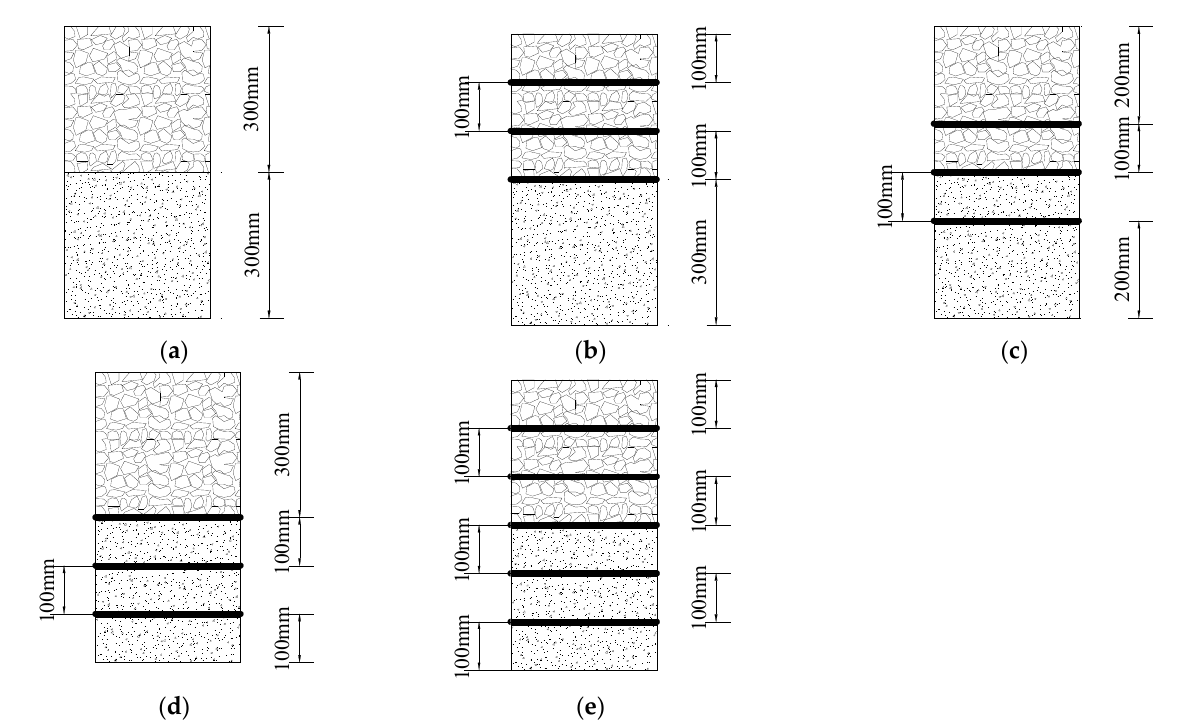
Figure 6. Geogrid and waste tyre reinforcement arrangement: ( a ) unreinforcement (UR); ( b ) upper reinforcement (BGT1/T1); ( c ) central reinforcement (BGT2/T2); ( d ) lower reinforcement (BGT3/T3); ( e ) all reinforced (BGT5/T5).